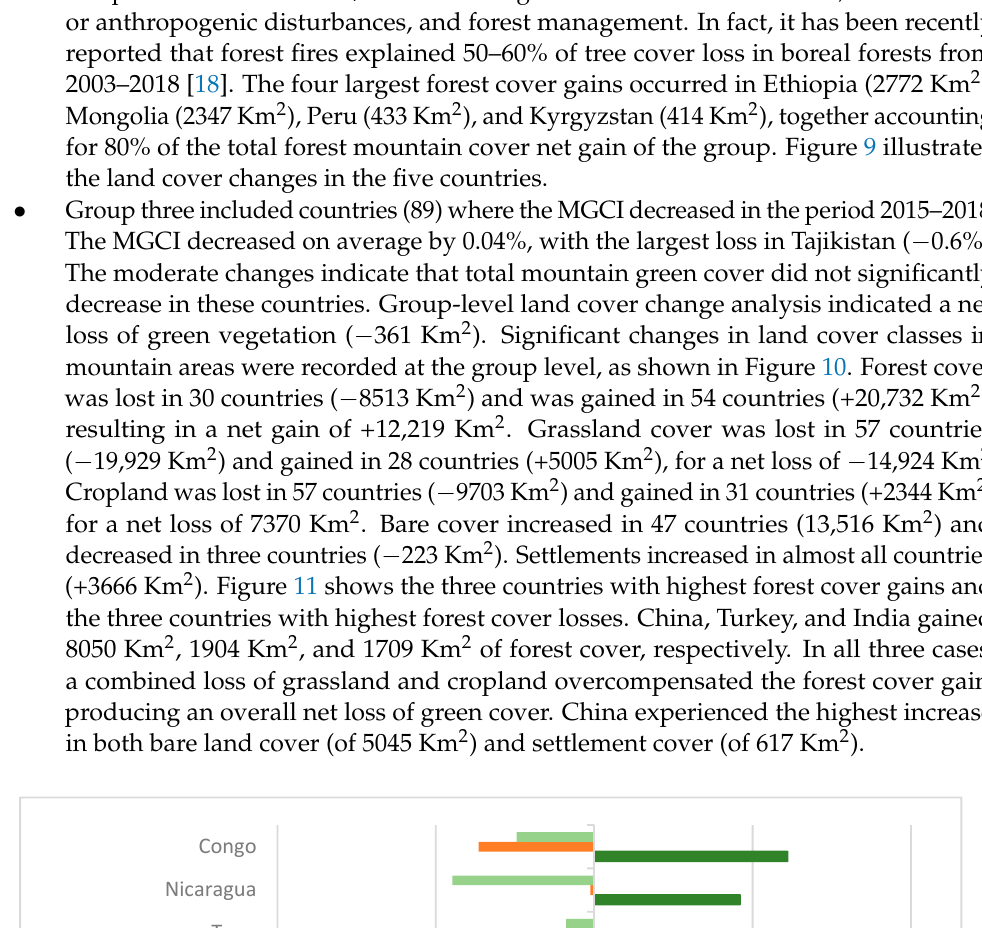
Figure 6. Number of countries experiencing negative, positive, or no change in MGCI from 2015 to 2018.